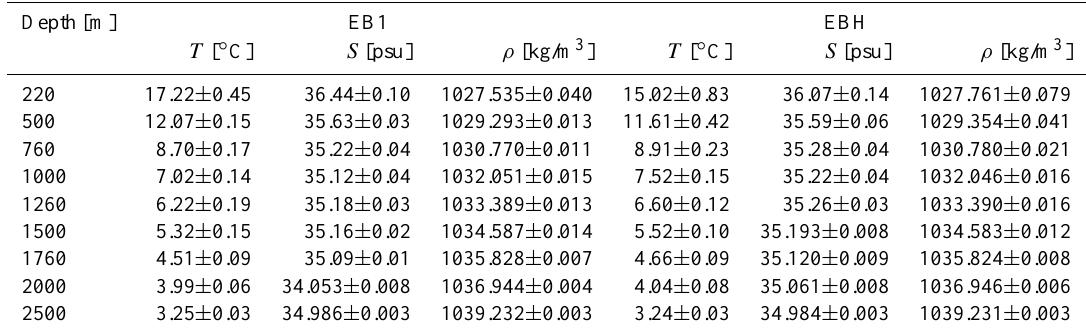
Table 4. Time mean and standard deviation at selected depth levels between the surface and 2500m of temperature ( T ), salinity ( S ), and in- situ density ( ρ) at EB1 and EBH. The time mean and standard deviation is computed for the period when both EB1 and EBH have full-depth measurements (13 April 2005 to 14 October 2007).